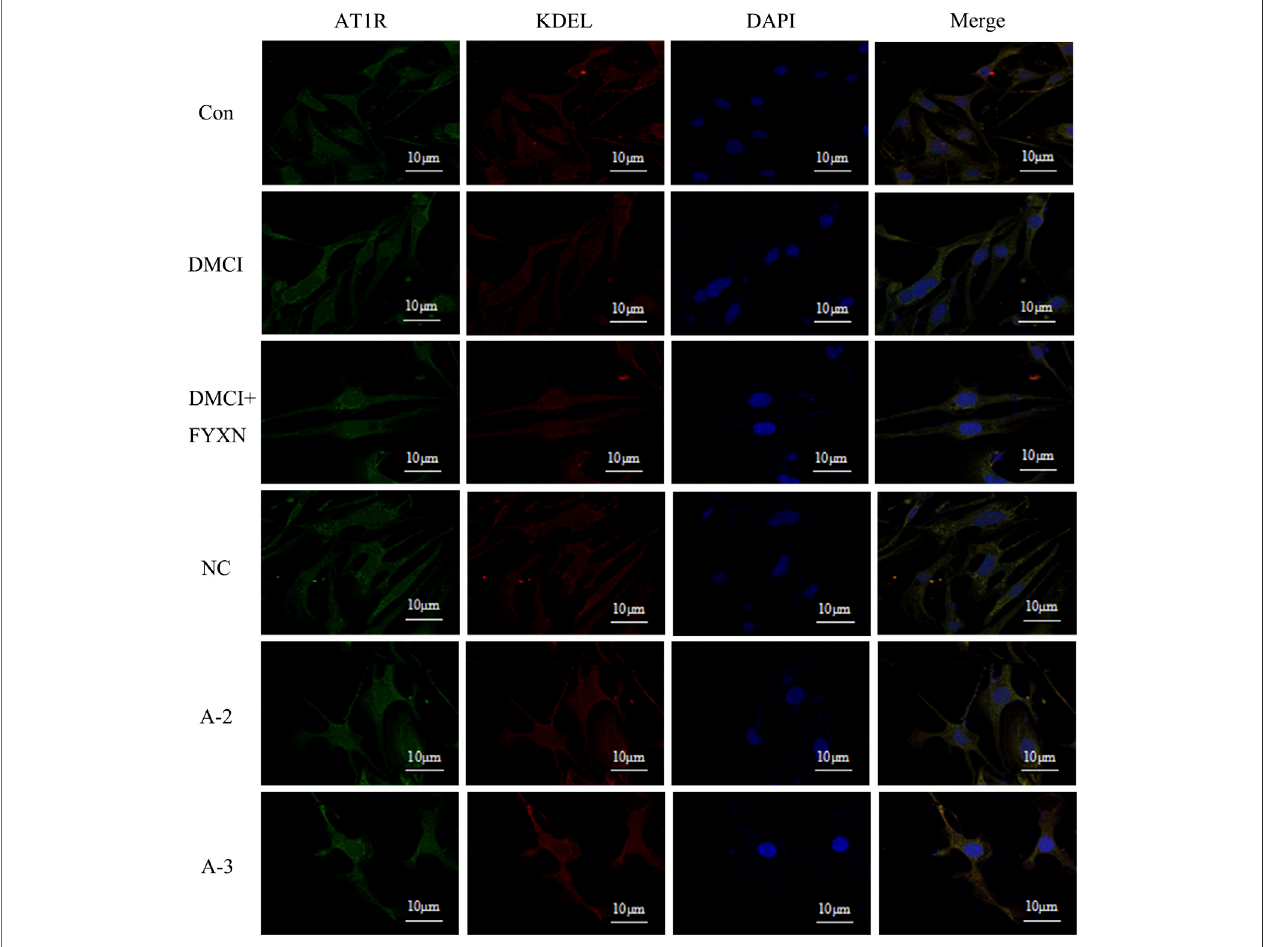
FIGURE13 | Immuno fl uorescence stainingwas used todetect the expression ofAT1R on themembrane and endoplasmic reticulum in BMECs treated with FYXN serum. A2 and A3 are Rab1a siRNA sequences respectively.